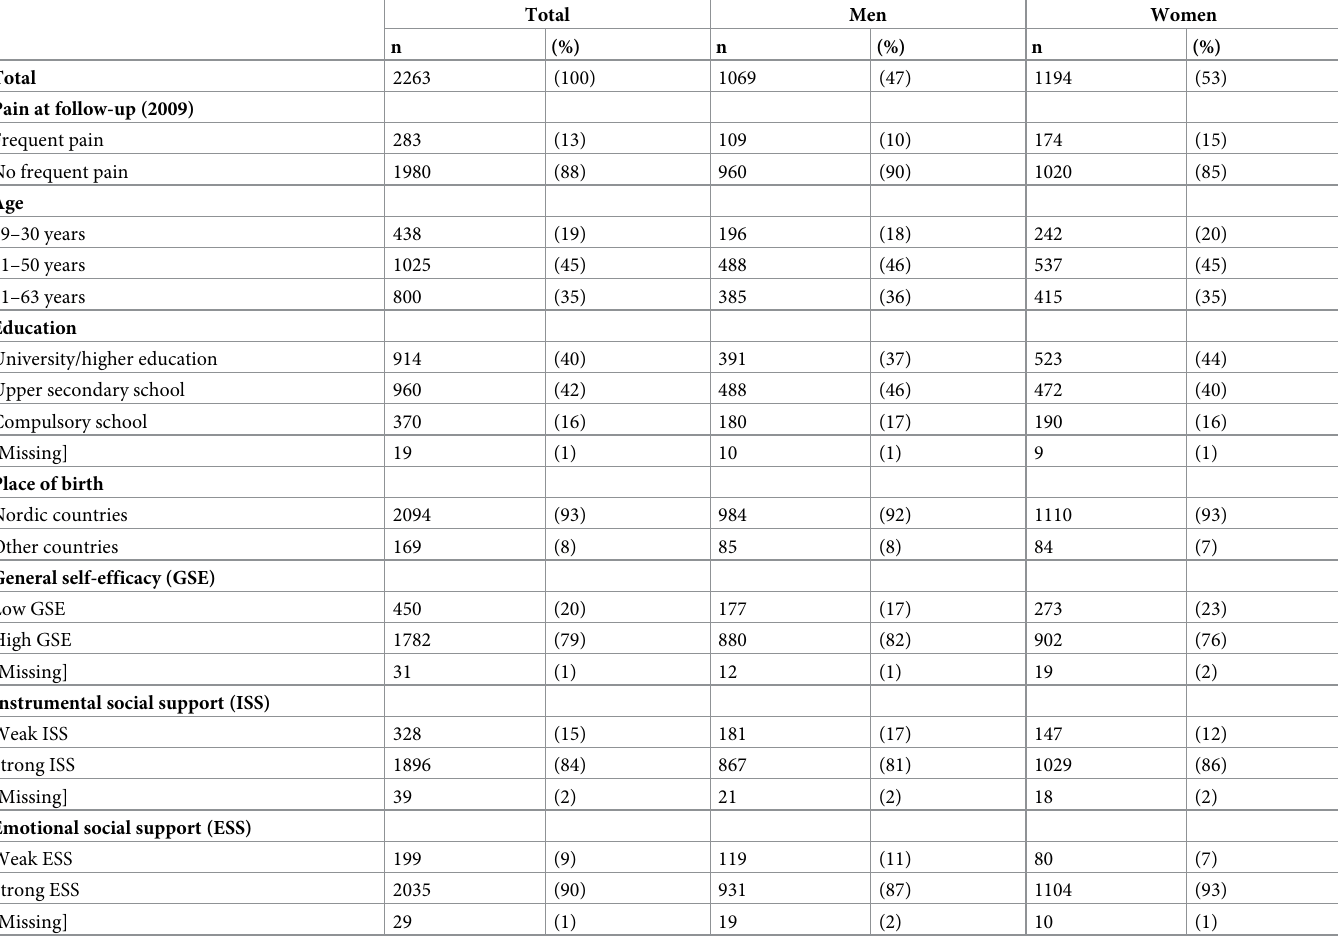
Table 1. Characteristics of the study population. Total Men